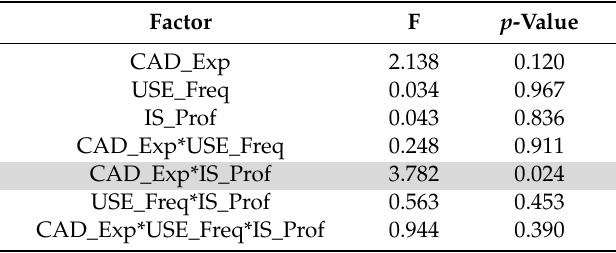
Table2. F statisticandcriticallevelvaluesfortheseveralconsideredfactorsandtheirpossiblecombinations. Factor F p -Value